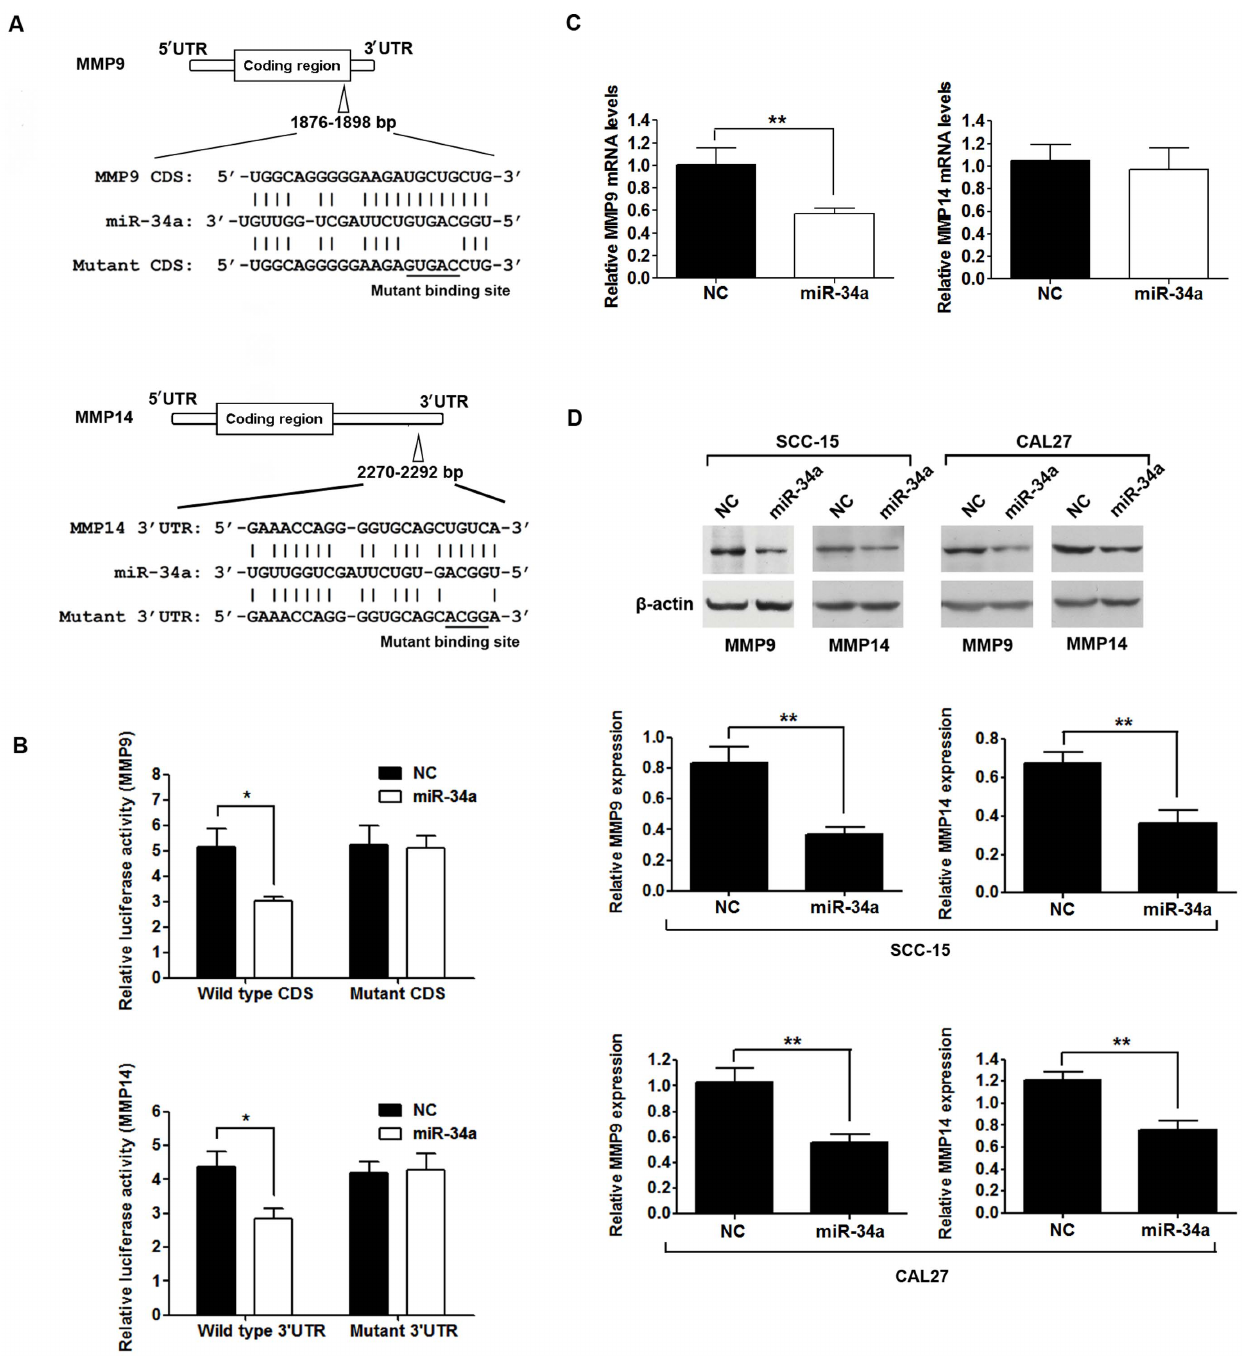
Figure 2. miR-34a targets MMP9 and MMP14. (A), The sequence of miR-34a (middle) matches the coding sequence (CD) of MMP9 and 3 9 untranslated region (UTR) of MMP14 (top). Bottom, mutations of the CD of MMP9 and 3 9 UTR of MMP14. (B), miR-34a inhibited wild-type, but not mutated MMP9 CD and MMP14 3 9 UTR luciferase reporter activity. CAL27 cells were co-transfected with firefly luciferase reporter plasmids containing wild type or mutant MMP9 CD and MMP14 3 9 UTR, and pRL-TK plasmid (a plasmid expressing rellina luciferase) and pcDNA3.0-miR-34a (miR-34a) or pcDNA3.0 (NC) as indicated. After 24 h, firefly luciferase activities were measured and normalized by use of renilla luciferase activities. Data were presented as mean 6 SD ( * P , 0.05). (C), The relative MMP9 and MMP14 mRNA levels determined by qRT-PCR in miR-34a or NC transfected CAL27 cells ( * P , 0.01). (D), Inhibition of the expression of MMP9 and MMP14 proteins. Representative Western blotting image (top) and the quantification (bottom) of MMP9 and MMP14 proteins in miR-34a transfected SCC-15 and CAL27 cells. b -actin was used as internal control and was also detected by Western blot ( ** P , 0.01).